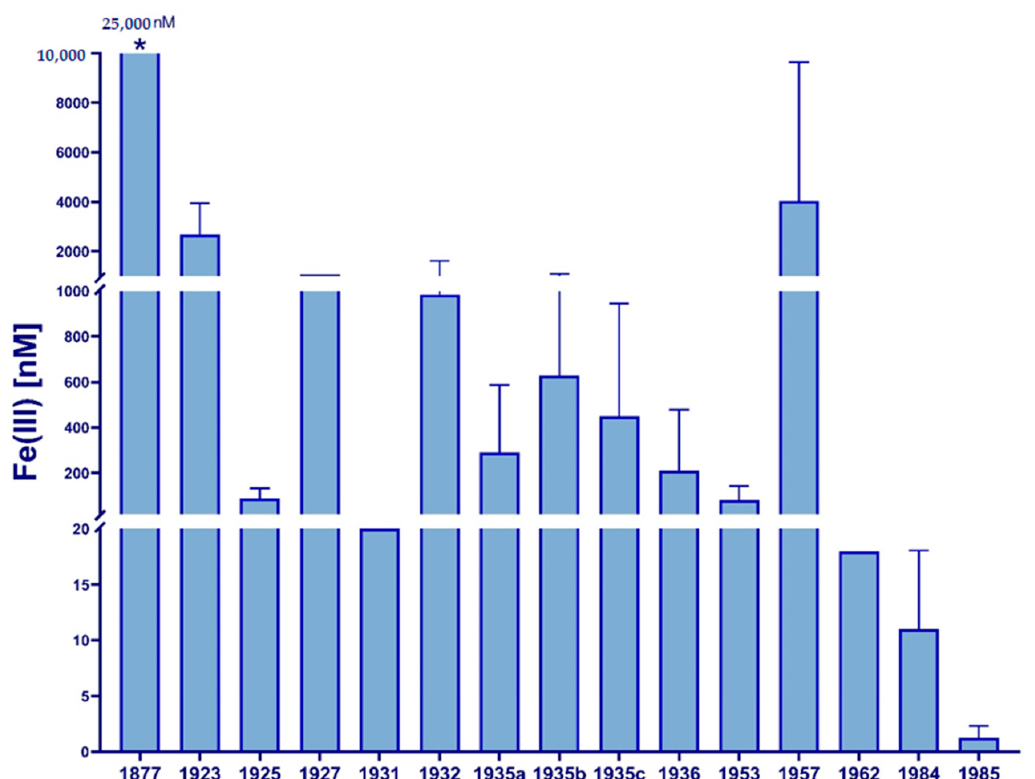
Figure 1. Historical overview of marine iron concentrations, as reviewed by de Baar (1994) [28]. * Proposed concentration based o ff data supposedly published by Schmidt in 1874 [29] and 1877